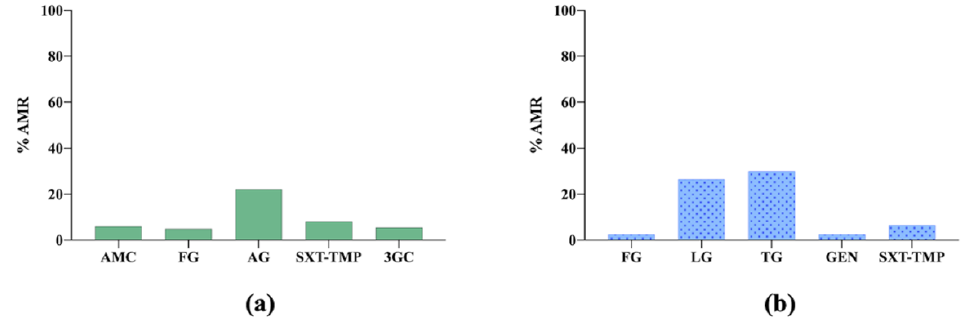
Figure 2. ( a ) Antimicrobial resistance (AMR) prevalence in Escherichia coli isolated from dogs and cats in Denmark. AMC: amoxicillin–clavulanic acid; FG: fluoroquinolones group; AG: aminopenicillins group, SXT-TMP: sulfamethoxazole–trimethoprim; 3GC: third-generation cephalosporins. ( b ) Antimicrobial resistance (AMR) prevalence in Staphylococcus pseudintermedius isolated from dogs and cats in Denmark. FG: fluoroquinolones group; LG: lincosamides group; TG: tetracyclines group; GEN: gentamicin; SXT-TMP: sulfamethoxazole – trimethoprim.